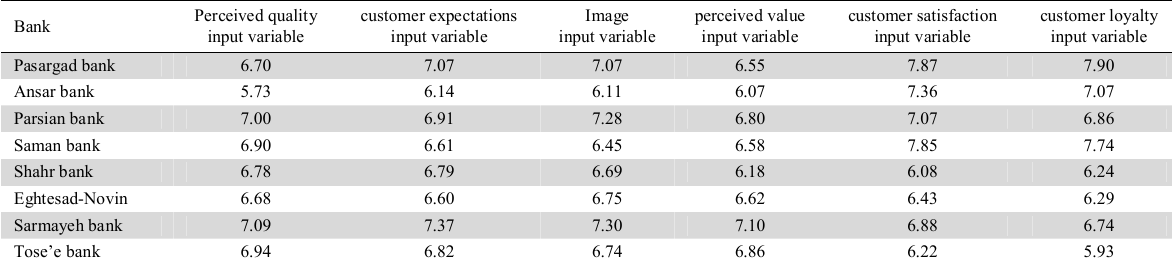
Crisp values output-orientated CCR model